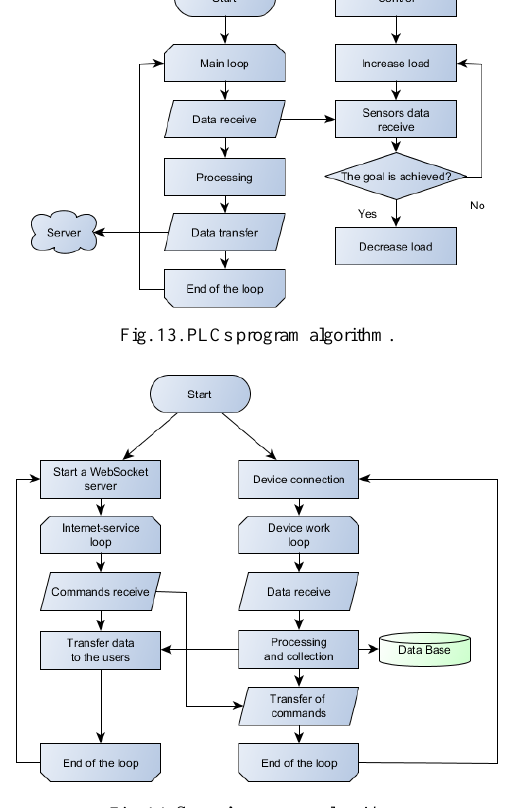
Fig. 14. Server’s program